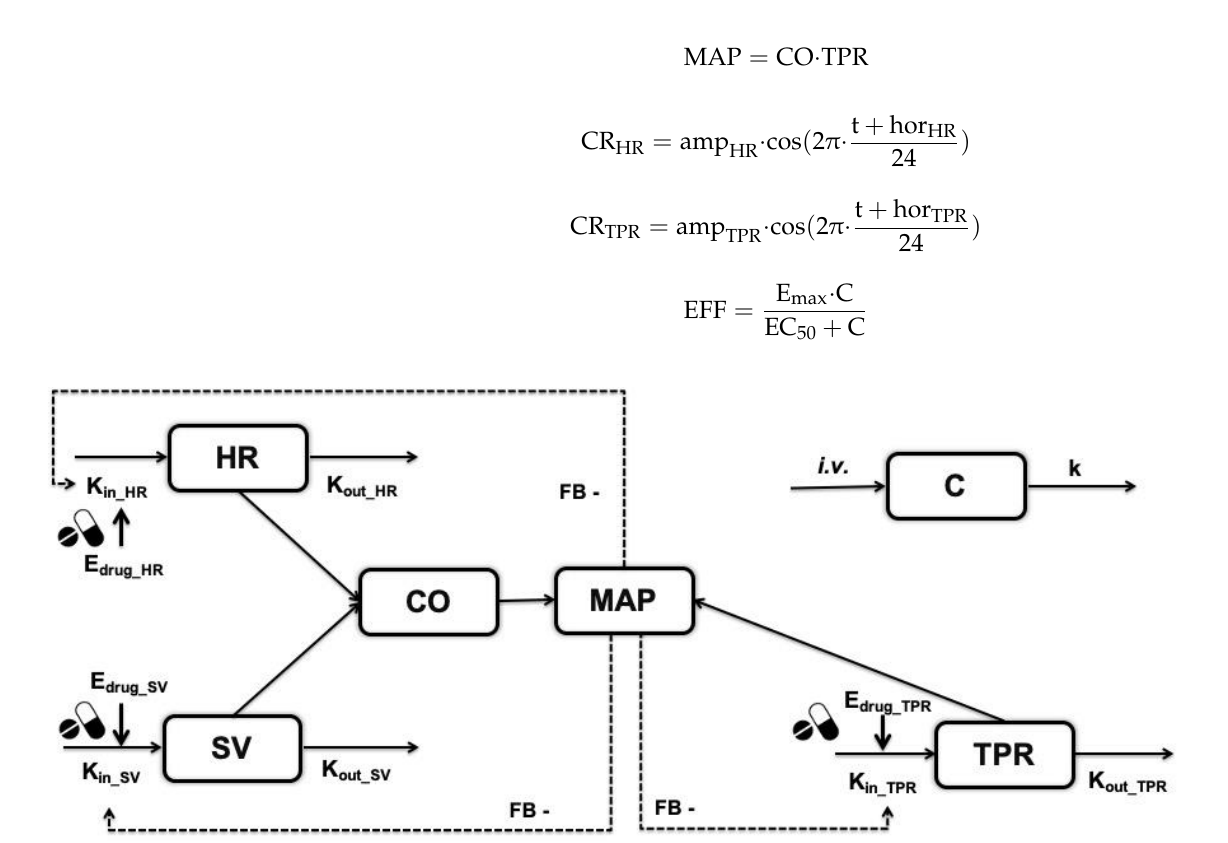
Figure 1. Model structure of the CVS model consisting of five hemodynamic variables of HR, SV, TPR, CO, and MAP and a one-compartment pharmacokinetic model of the hypothetical drug [7]. CO is defined as the product of HR and SV, while MAP is the product of CO and TPR. The drug affects the production rate of HR, SV, or TPR. C: drug concentration (ng/mL); HR: heart rate (beats/min); SV: stroke volume (mL/beat); TPR: total peripheral resistance (mmHg∙min/mL); CO: cardiac output (mL/min); MAP: mean arterial pressure (mmHg); FB: feedback effect of MAP (mmHg −1 ); E drug : drug effect on three primary effect sites. K in : production rate constant (K in_HR : beats*h −1 /min, K in_SV : mL*h −1 /beat, K in_TPR : mmHg*min*h −1 /mL); K out : dissipation rate constant (h −1 ); k: elimination rate constant of the hypothetical drug (h −1 ).